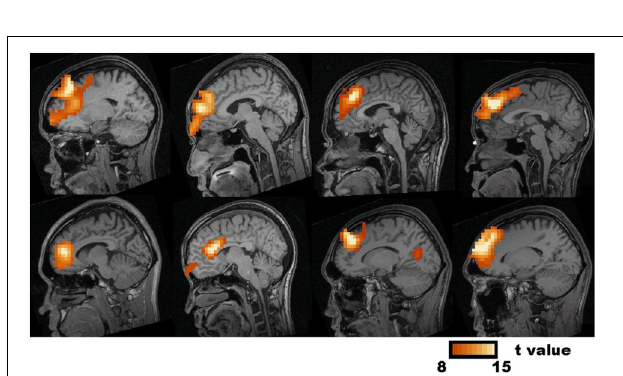
FIGURE 3 | Synthetic Aperture Magnetometry analysis of eight subjects who had prominent medial frontal source power changes in theta frequency band in individual analysis. Statistic parametric maps (SPM) of the Frontal Midline Theta source-current density in individual subjects are projected onto sagittal slices of the subject’s MRI. The color bar represents t -values.